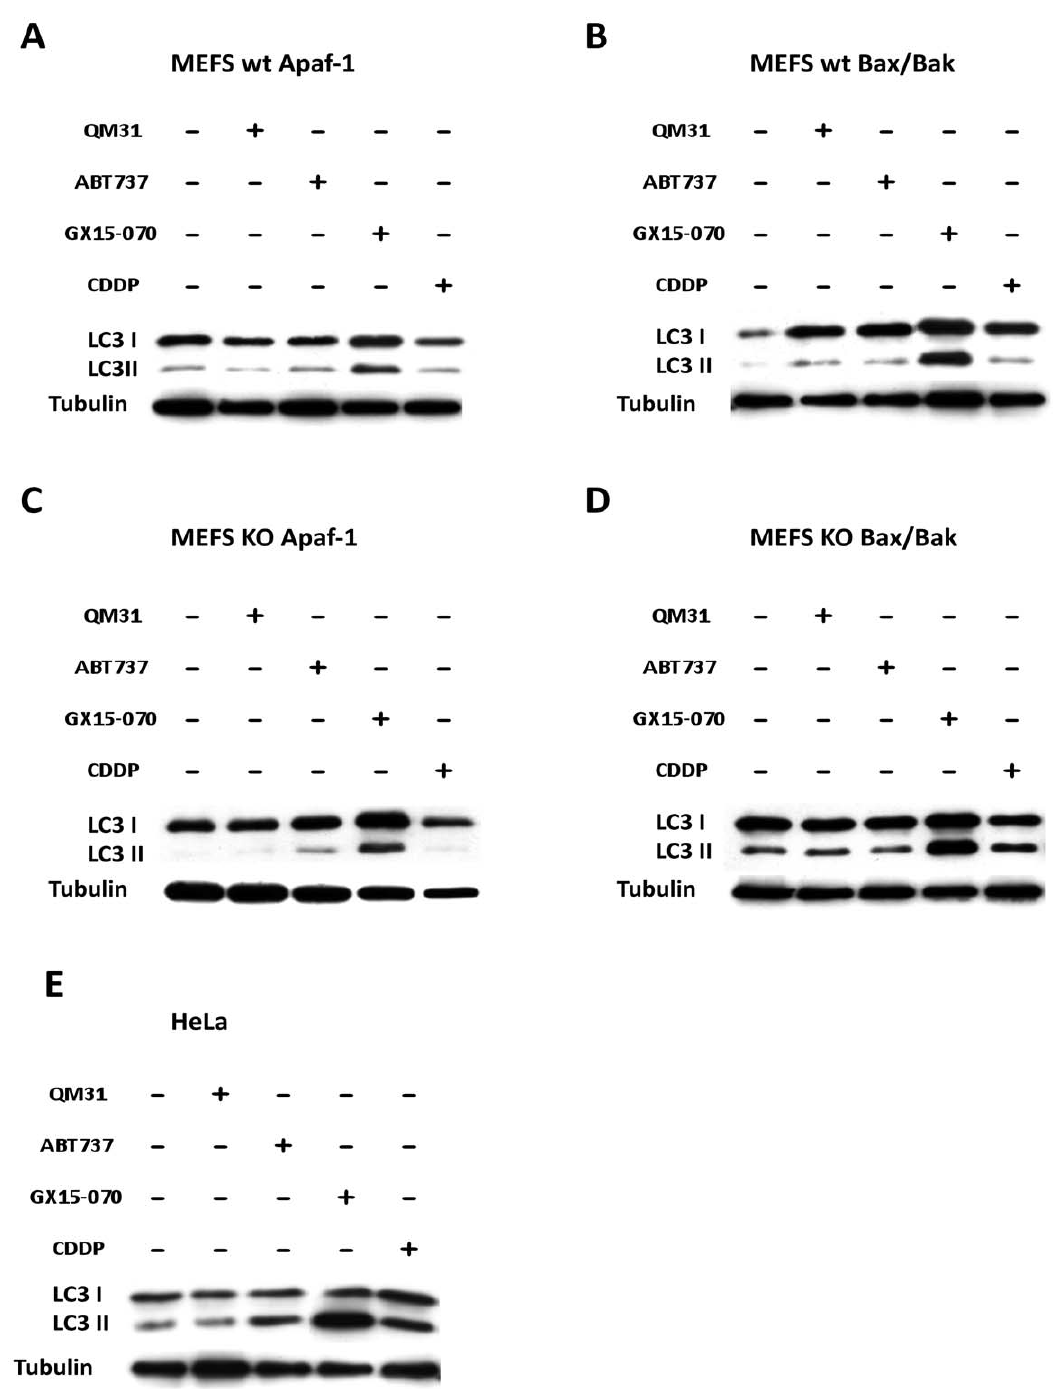
Figure 5. GX15-070 promotes the activation of the autophagic pathway via LC3 in all the cell lines. ( A–E ) LC3 detection in MEFS wt Apaf-1, MEFS wt Bax/Bak, MEFS KO Apaf-1, MEFS KO Bax/Bak and HeLa cells treated with ABT737 (25 m M), GX15-070 (1 m M), CDDP (30 m M ) and QM31 (10 m M).